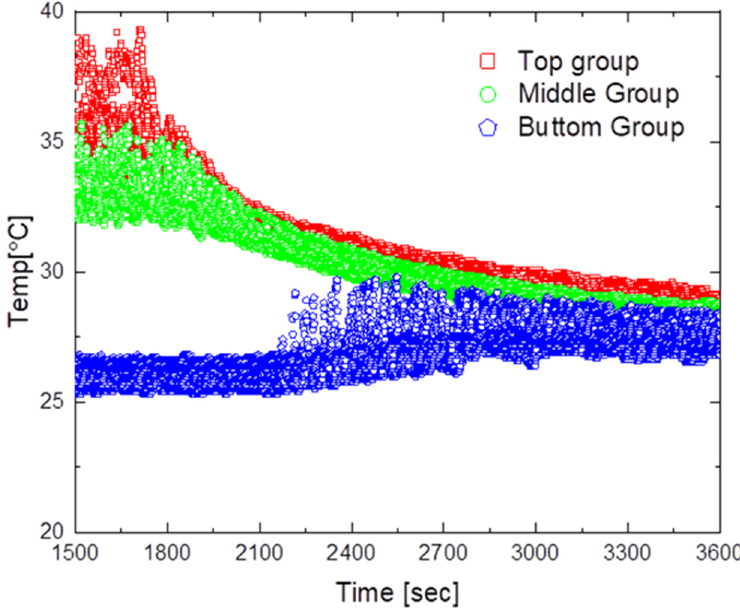
Figure 11. Temperature distribution by natural convection.